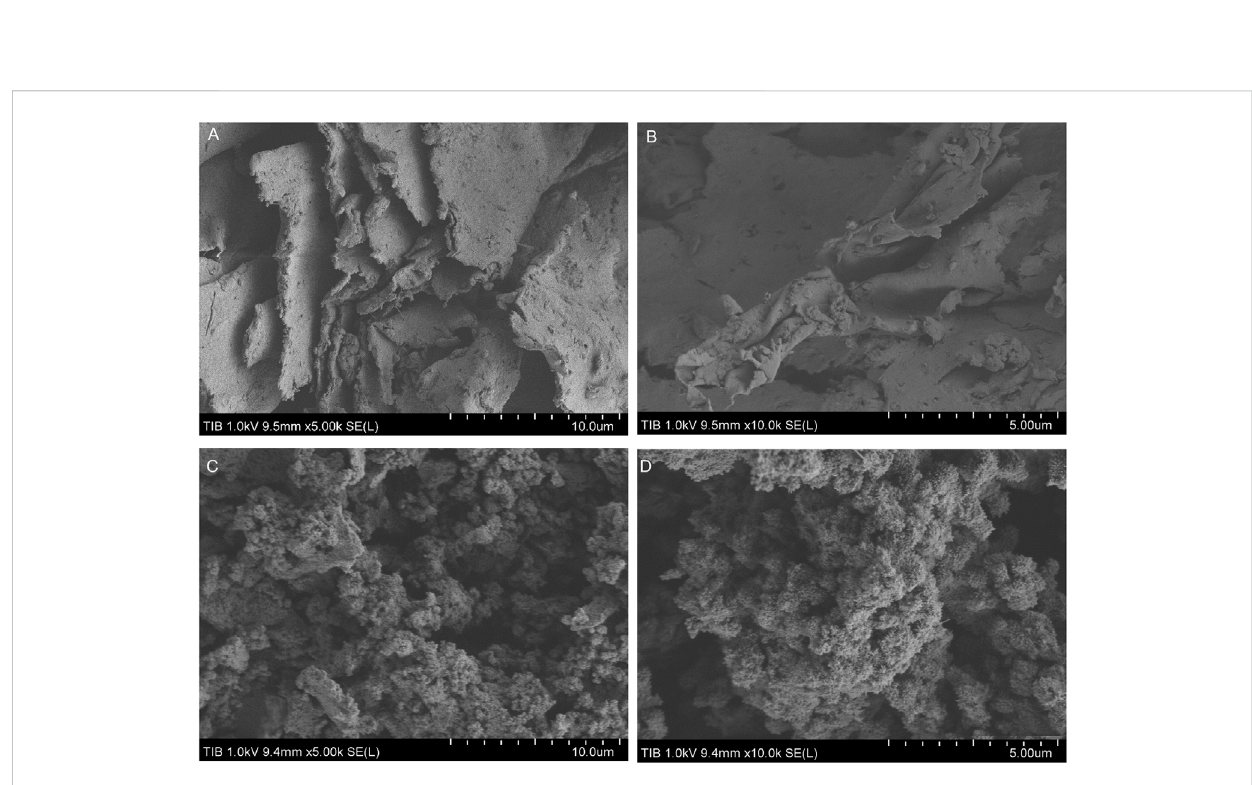
FIGURE 6 SEM micrograph images of puri fi ed bio fl occulant (A,B) and bio fl occulant aggregation with the acid mine wastewater (C,D) .